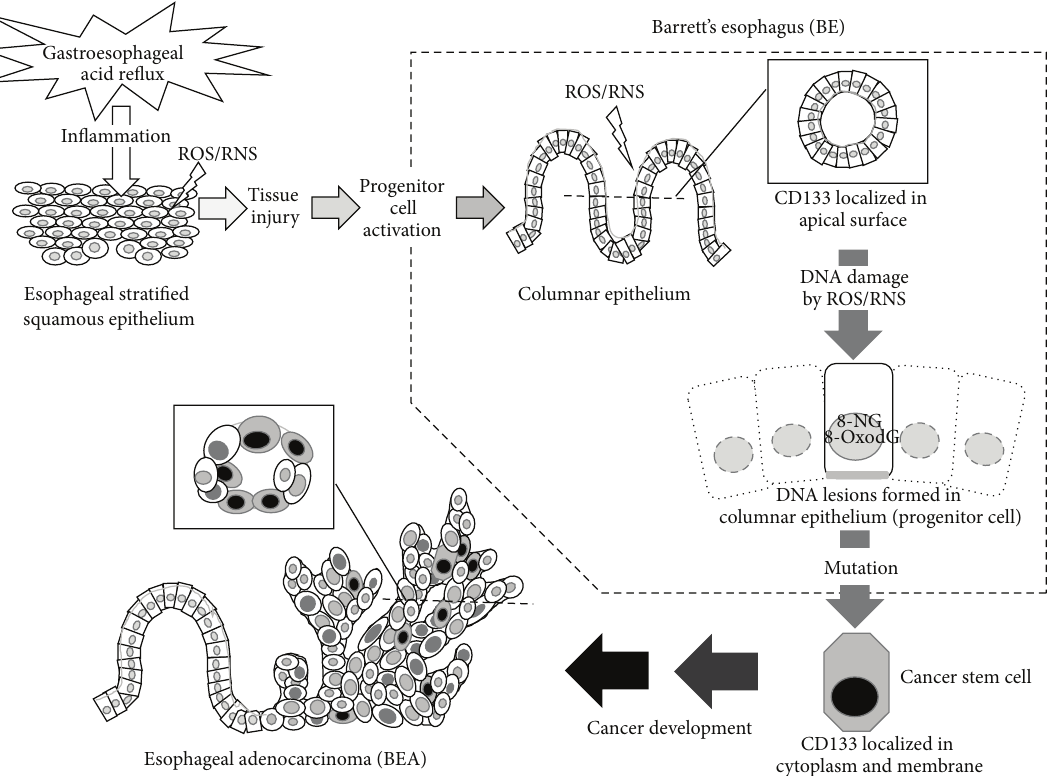
Figure 4: Proposed mechanism of Barrett’s esophageal carcinogenesis (BEA) derived from Barrett’s esophagus (BE). GERD induces inflammatory responses and tissue injury, which mediate intestinal dysplasia and CD133 expression in apical surface of columnar epithelial cells. Inflammatory responses also mediate DNA damage in these cells with progenitor-like properties, which may lead to accumulation of mutations. Under such conditions, the alteration in CD133 localization to cell membrane and the cytoplasm occurs, and the cells acquire the property of cancer stem cells, leading to BEA